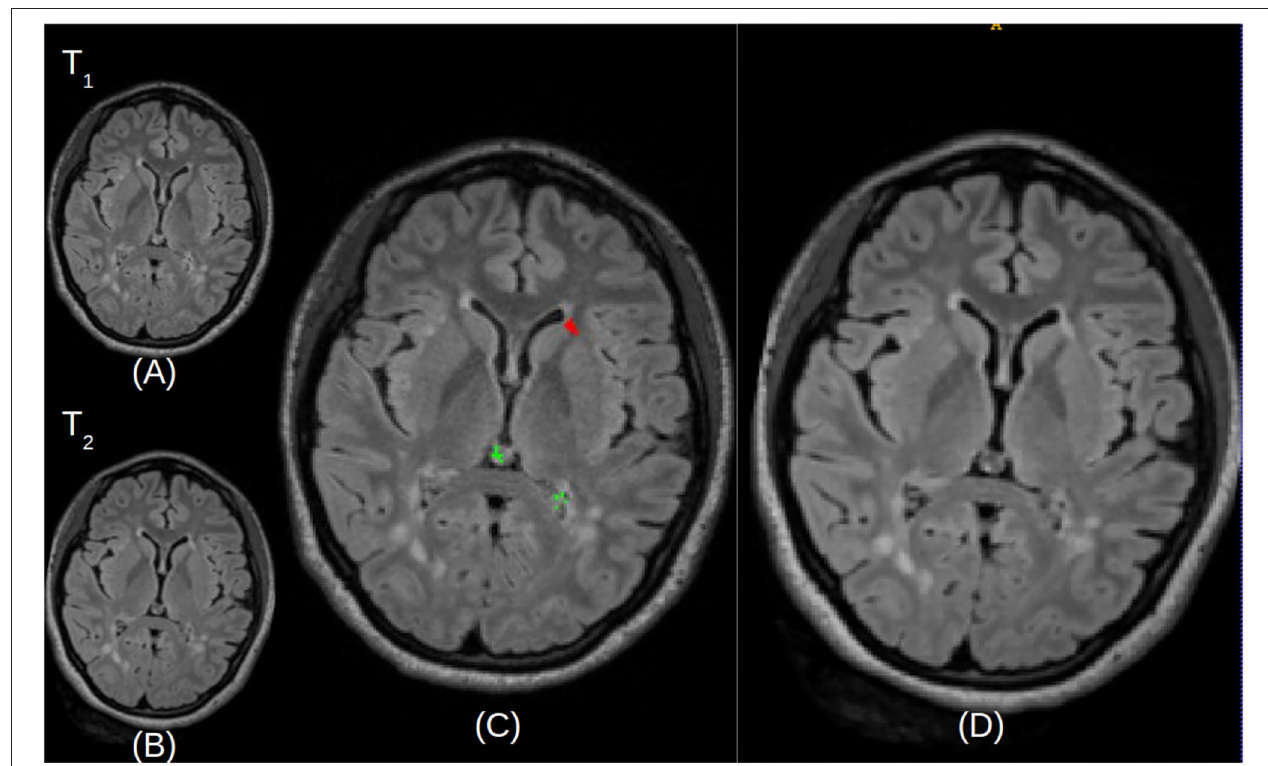
FIGURE 6 | Illustrative examples of resulted images stored in the DICOM file format. (A,B) Represent the Timepoint-1 and Timepoint-2 scans of a given patient, respectively. (C) Describes Timepoint-2 (B) , with superimposed annotations for detected new lesions (depicted in red) and false positives (depicted in green). (D) Is a larger version of Timepoint-2 (B) without annotations, for visualization